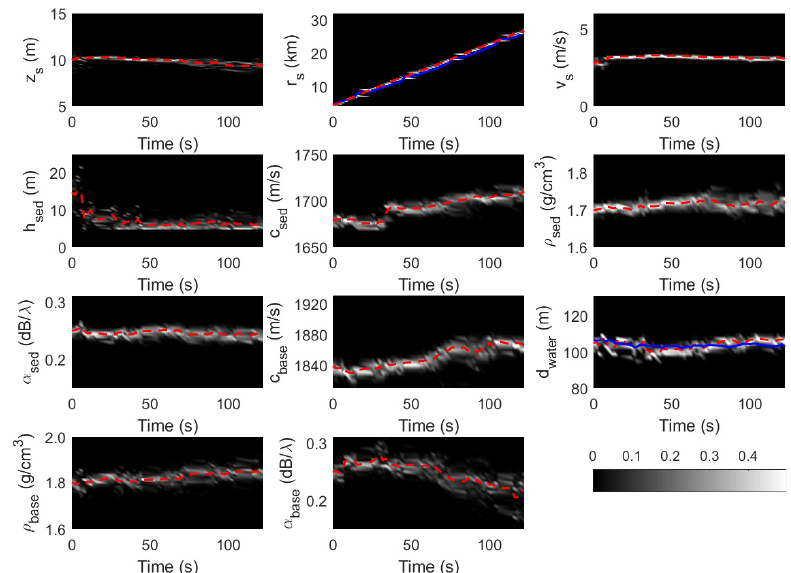
Figure 7. Tracking result for source and geoacoustic parameters by EnKPF together with true trajectories of source range r s and water depth d water (blue lines). The red dashed lines are time-evolving estimated results.